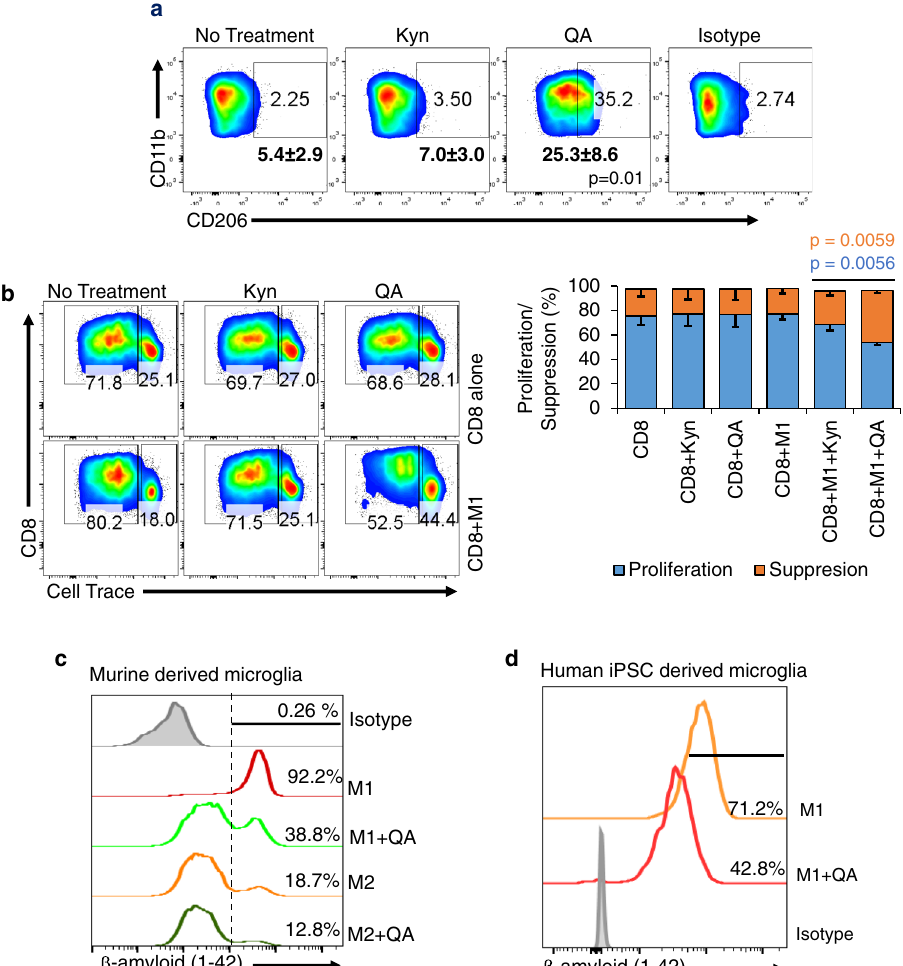
Fig. 3| QAinducesanimmunesuppressivephenotypetoM1macrophagesand microglia. a M0 macrophages harvested from the bone marrow of C57BL/6 mice were polarized to M1 macrophages with LPS (100ng/ml) and IFN γ (50ng/ml) for 24 – 36h ±Kyn or QA (20 µ M) and gated for M2 macrophage markers (CD45+F4/ 80+CD11b+CD206+). Numbers represent mean±SD ( n =3 biologically inde- pendent samples/group). b The functional suppression of M1 macrophages polarized+/- Kyn or QA was performed using CD8/macrophage co-culture experimentswithCFSEdilution,asdescribedinFig.2.Bargraphdemonstratemean andSD( n =3biologicallyindependentsamples/group). c Murine-derivedmicroglia were matured in the presence of GM-CSF conditioning media and polarized